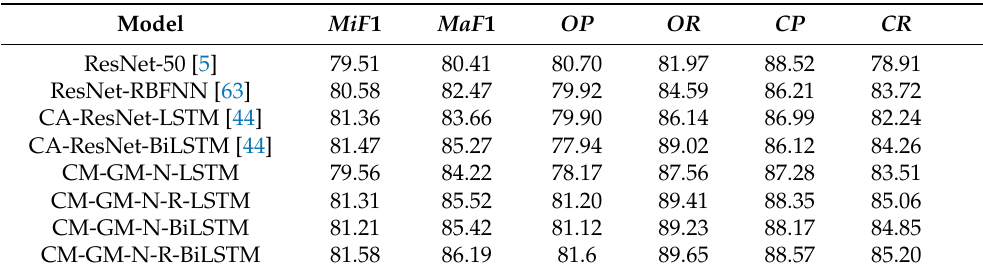
Table 1. The performance of different models on UC-Merced multi-label dataset.